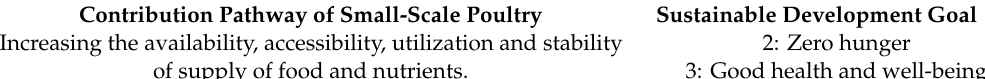
Table 3. Contributions of small-scale poultry to the UN Sustainable Development Goals [39,55]. Contribution Pathway of Small-Scale Poultry Sustainable Development